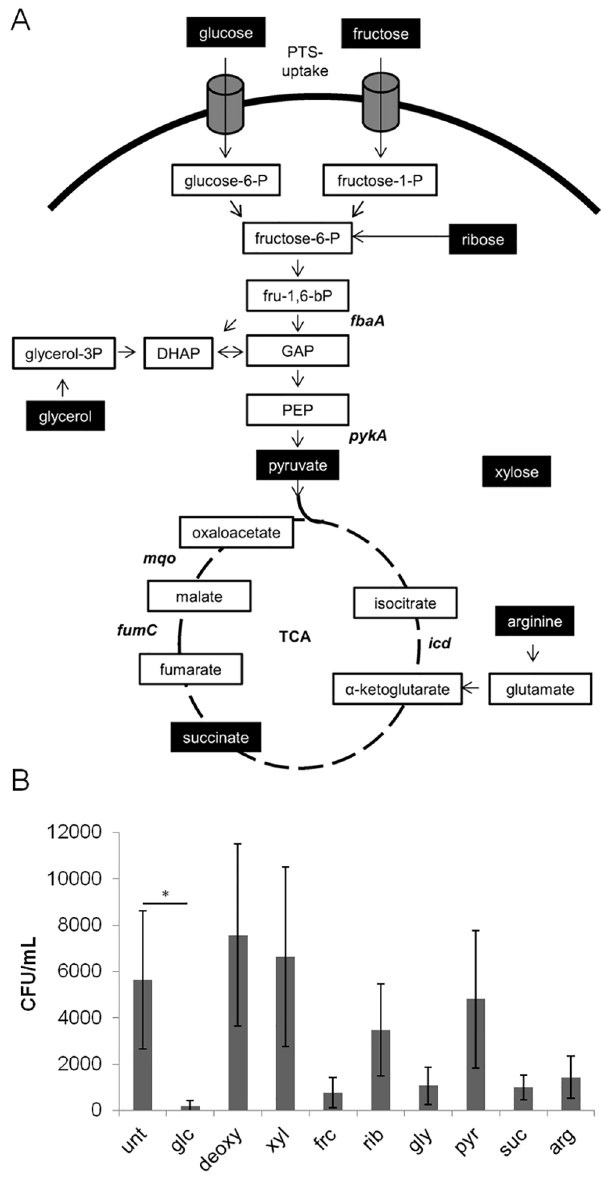
Fig 2. Influence of selected carbohydrates on DAP challenged S . aureus cultures. A) Schematic overview of tested metabolites and their entrance into the metabolism of S . aureus and genes responsible for selected metabolic reactions; fructose (fru), glyceraldehyde-3-phosphate (GAP), Dihydroxyacetone phosphate (DHAP), phosphoenolpyruvate (PEP). B) Selected compounds were added to final concentrations of 5 mM at t = 3h and the CFU values were determined after 24 hours. Groups were compared to the untreated control group by 1-way ANOVA with Dunnett's Multiple Comparison Test. * p < 0.05.